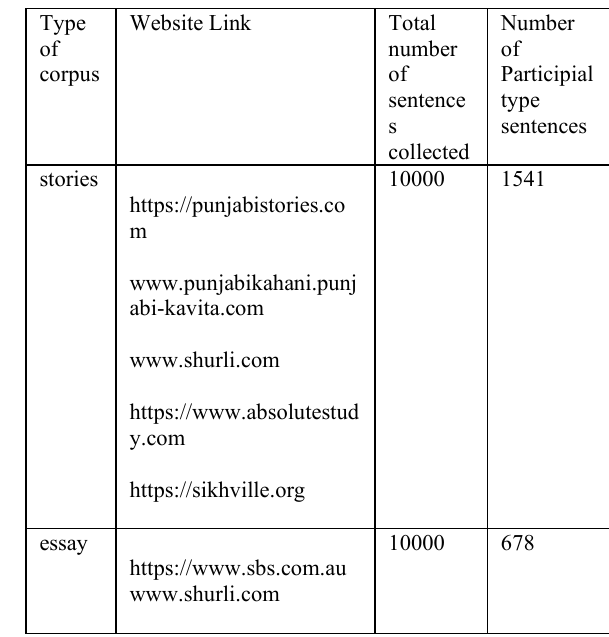
Table 5. Other Online